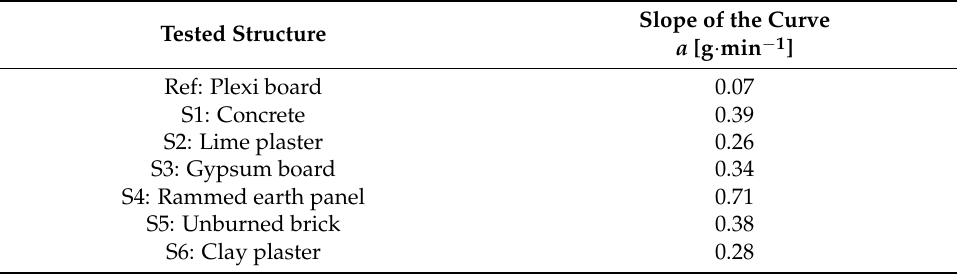
Figure 9. Water consumption during the experiment. Table 1. Slope of the water consumption curve in the interval of 20–60